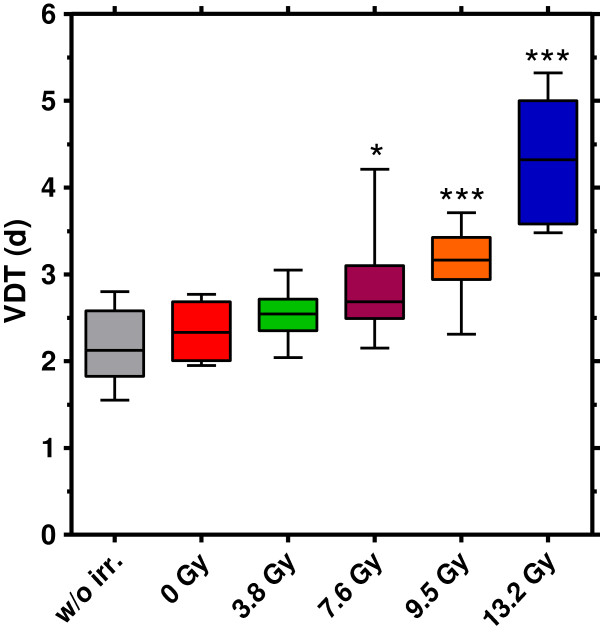
Dose dependent tumour volume doubling times for 200 kV X-ray irradiation. KHT tumour volume doubling times for the unirradiated control (8 mice) and after irradiation with 200 kV X-rays (0 Gy (4); 3.8 Gy (8); 7.6 Gy (10); 9.5 Gy (8); 13.2 Gy (7)) determined on basis of the tumour volume at which the animals were included in the experiment. Compared to the unirradiated control the VDT values for doses of 7.5 Gy and higher were significantly increased (*p < 0.05, ***p < 0.001).